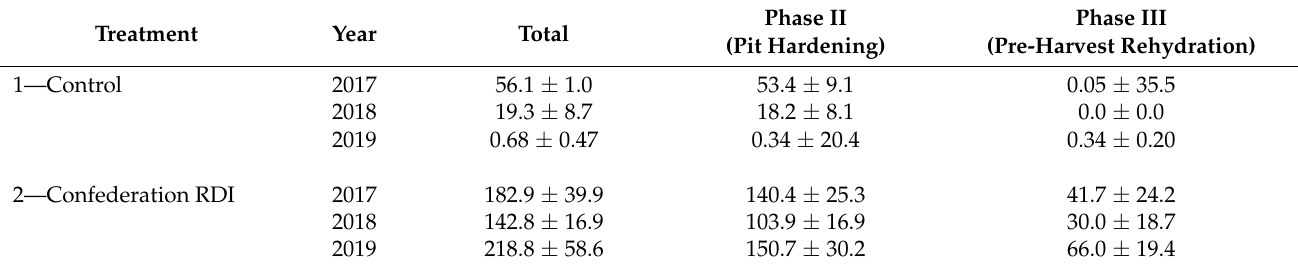
Table A2. Average water stress integral (SI, MPa × day) ( ± SE) in the irrigation treatments in the three years of the study.